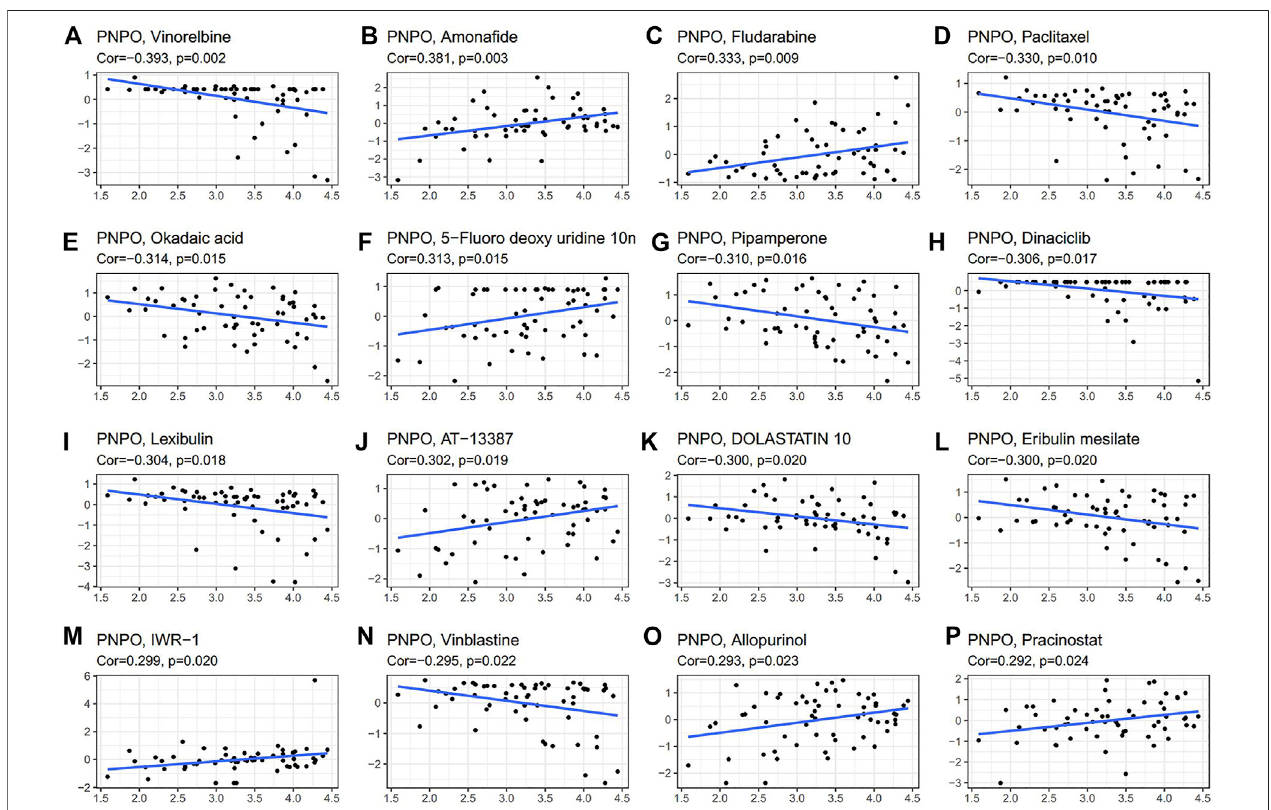
FIGURE 8 | Drug sensitivity analysis of PNPO. The expression of PNPO was associated with the sensitivity of vinorelbine (A) , amona fi de (B) , fl udarabine (C) , paclitaxel (D) ,okadaic (E) ,5- fl uorodeoxyuridine (F) ,pipamerone (G) ,dinaciclib (H) ,lexibulin (I) ,AT-13387 (J) ,dolastatin (K) ,eribulinmesilate (L) ,IWR-1 (M) ,vinblastine ( N) , allopurinol (O) , and pracinostat sensitivity ( P) .